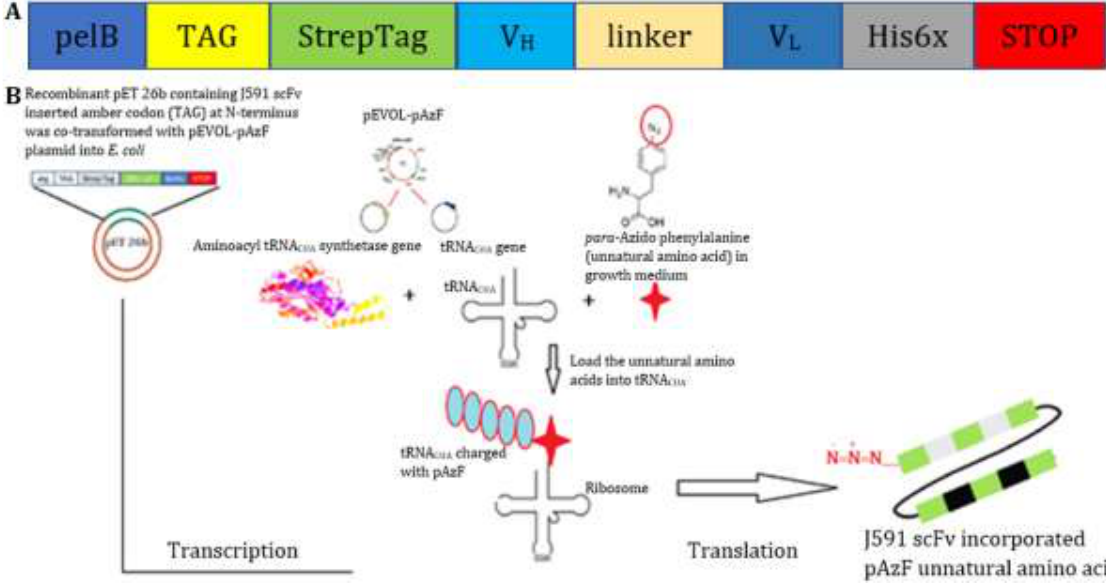
Figure 1. Design, cloning and expression of anti-PSMA. J591 scFv incorporated pAzF in periplasmic space of E. coli system. A) Plasmid design, pelB; promoter for periplasmic expression; TAG: amber stop codon for unnatural amino acid attachment site; StrepTag: strep tag coding sequence for purification purposes; VH: variable heavy chain sequence of J591 antibody; linker: flexible linker (G4S) 3 ; VL: variable light chain